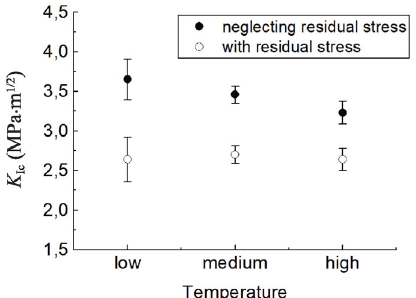
Fig. 19 Fracture toughness of CVD SiC coatings deposited at different temperatures with and without taking residual stress into